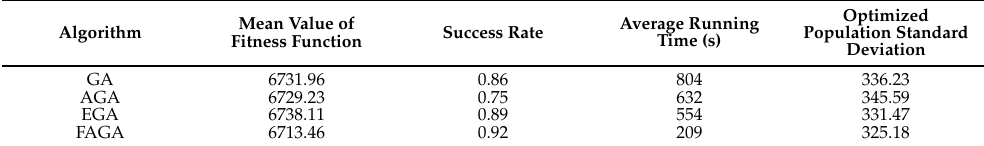
Table 12. Statistical indicators of algorithms run 30